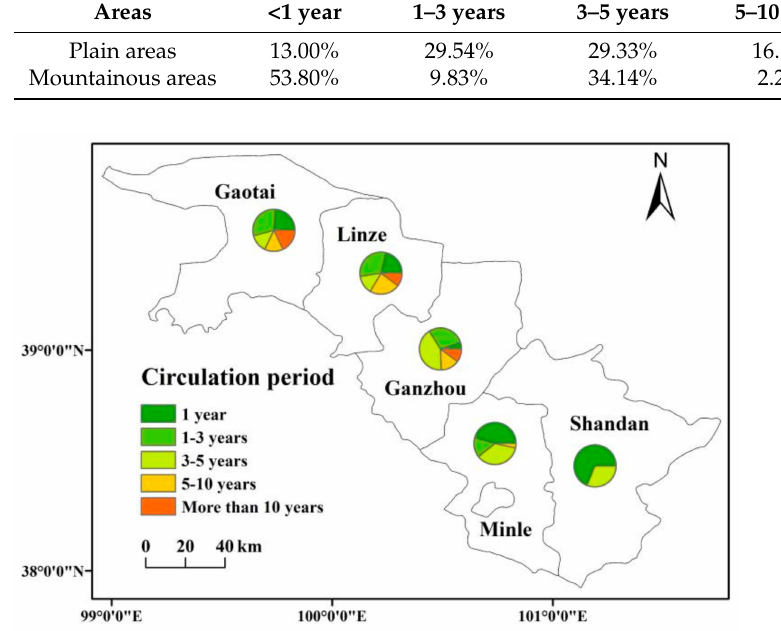
Figure 5. Spatial distribution of different circulation period in Zhangye